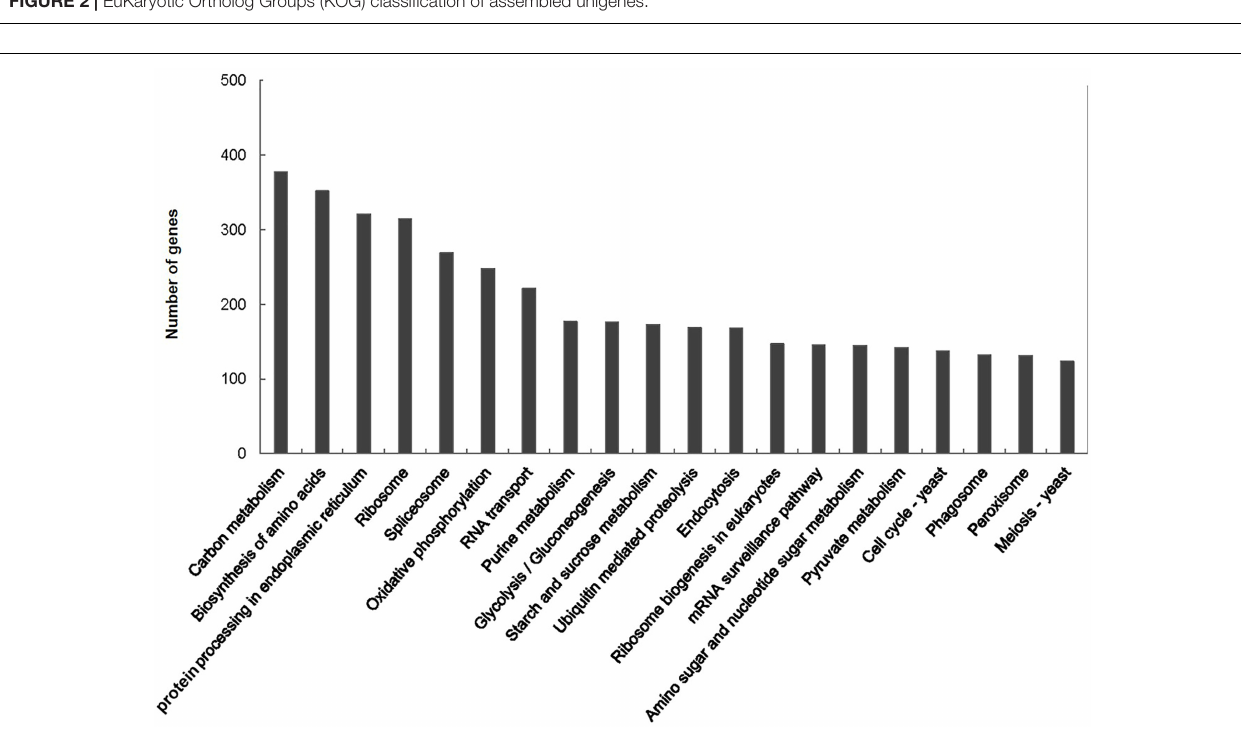
FIGURE 3 | Kyoto Encyclopedia of Genes and Genomes (KEGG) classification of assembled unigenes.